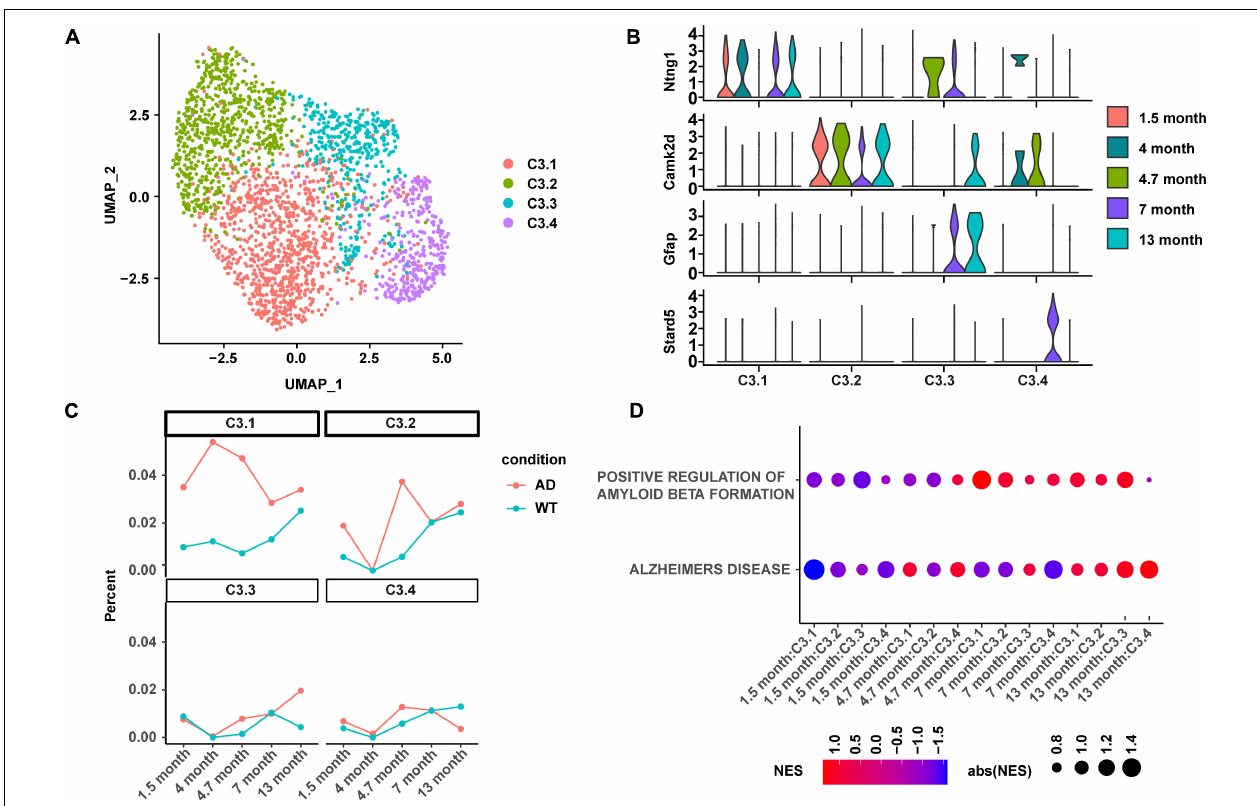
FIGURE 4 | Subtype analysis of C3:Ex.Neuron revealed similarity between C3.1 and C3:Ex.Neuron. (A) UMAP plot showing four subtypes of C3:Ex.Neuron. Each dot represents a cell colored according to each cluster. (B) Violin plots showing the distribution of the subtype-specific markers of C3:Ex.Neuron. (C) The ratio of four excitatory neuron subtypes between AD and WT mice at 1.5, 4, 4.7, 7, and 13 months. (D) GSEA analyses reveal the enriched AD directly associated terms in applicable subtypes of C3:Ex.Neuron at 1.5, 4.7, 7, and 13 months of AD and WT mice. UMAP, Uniform Manifold Approximation and Projection; GESA, Gene